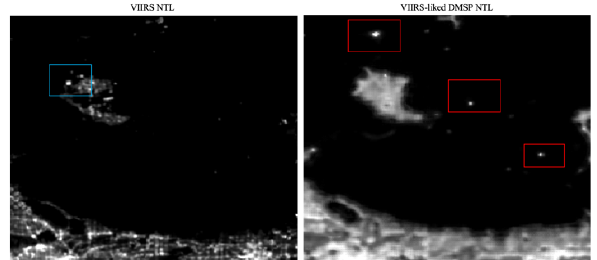
Figure 5. A zoomed-in comparison between VIIRS NTL and VIIRS-liked DMSP NTL data.